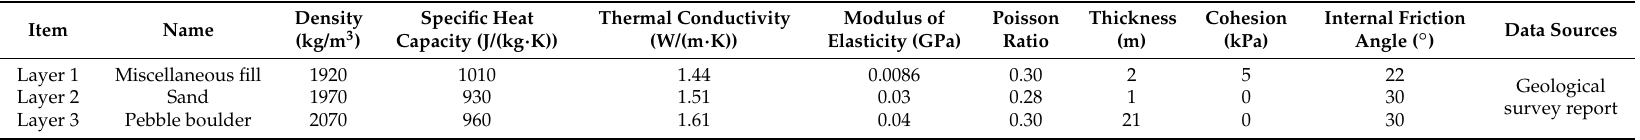
Table 1. Soil layer